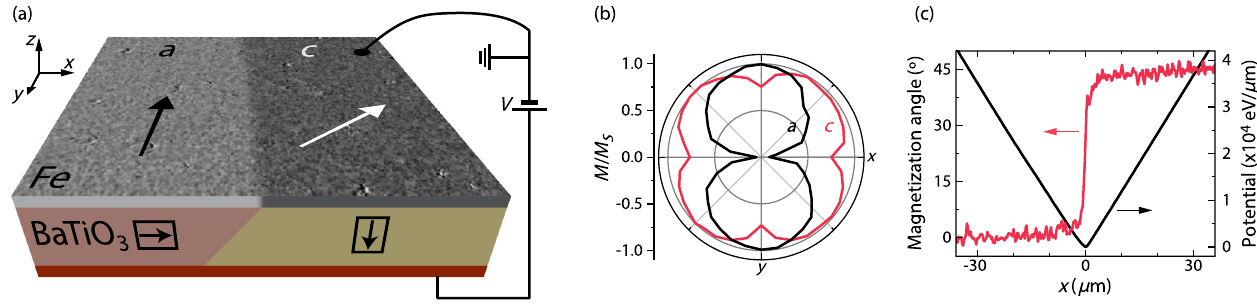
FIG. 1. (a) Schematic illustration and Kerr-microscopy image of the Fe = BaTiO 3 heterostructure with ferroelectric a and c domains. Arrows indicate the direction of ferroelectric polarization in the BaTiO 3 substrate and the direction of magnetization in the Fe film in zero magnetic field. Measurements of electric-field-driven magnetic domain-wall motion are conducted by contacting the Fe = Au layer to ground and applying bias-voltage pulses to the back side of the BaTiO 3 substrate. (b) Polar plots of the remanent magnetization on top of the a domain (black line) and c domain (red line). (c) Measured profile of the magnetic domain wall in (a) (red line) and the calculated pinning potential (black